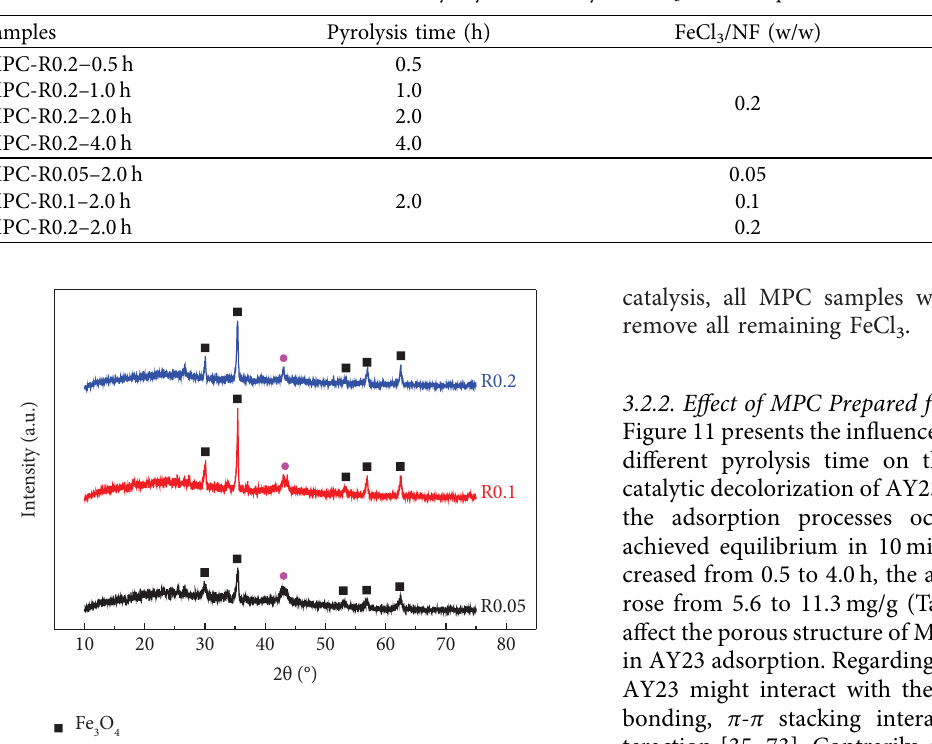
Table 1: Pyrolysis efciency of FeCl